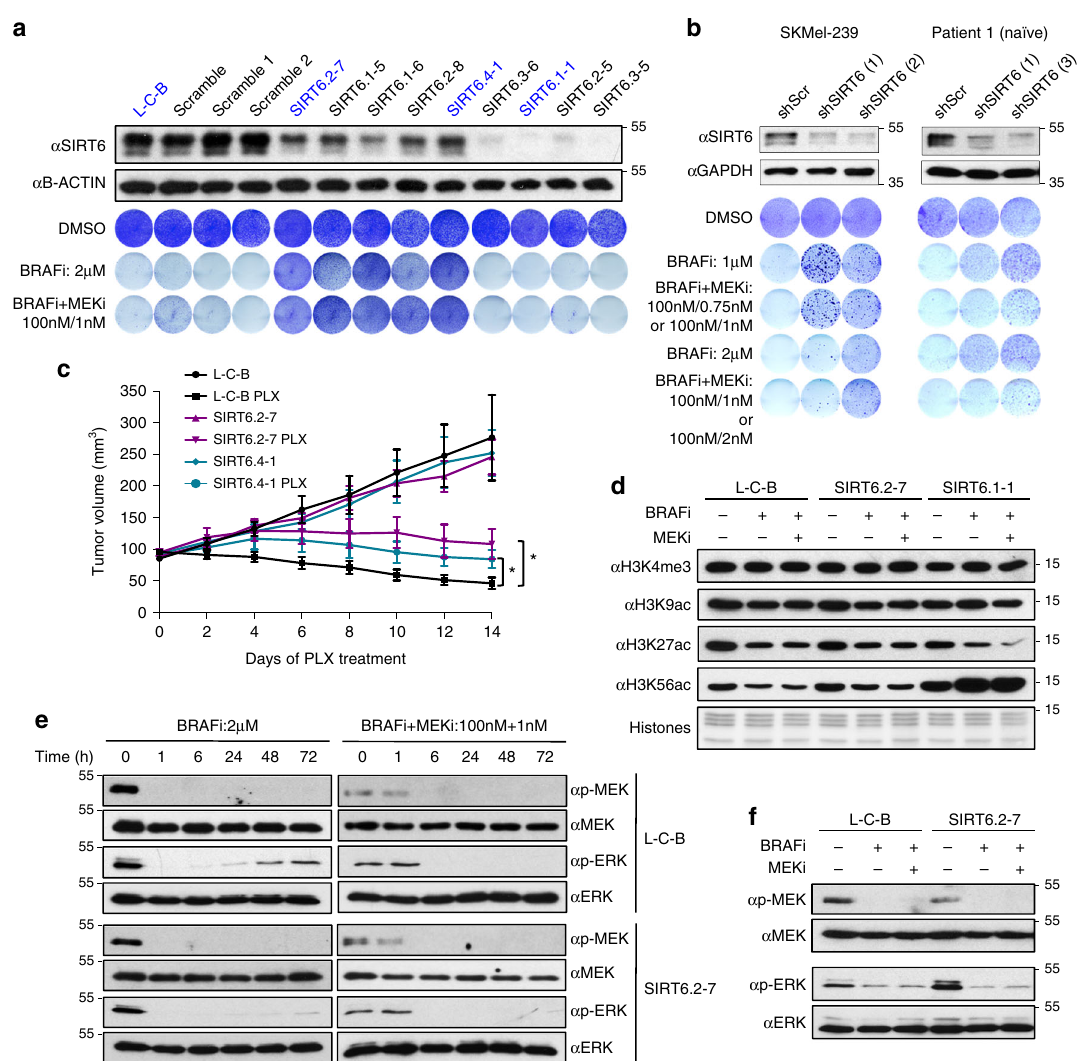
Fig. 2 SIRT6 haploinsuf fi ciency promotes resistance to MAPKi in BRAF V600E melanoma cells. a Immunoblot of SIRT6 in the indicated whole-cell lysates of SKMel-239 clonal CRISPR cell lines. B-Actin was used as a loading control (top; CRISPR clones used for follow-up experiments are indicated in blue). SKMel-239 cells were seeded at the same density and cultured in DMSO (1 week) or in the presence of the MAPKi (2 weeks) as indicated (bottom). b Immunoblot of SIRT6 in the indicated whole-cell lysates in SKMel-239 (left) and Patient 1 treatment-naive STC (right). GAPDH was used as a loading control. SKMel-239 and Patient 1 cells infected with control shRNA (scrambled) or shRNAs against SIRT6 (1, 2, or 3) were seeded at the same density and cultured in DMSO (1 week) or in the presence of MAPKi (4 and 5 weeks, respectively). c Quanti fi cation of tumor volume in nude mice bearing xenograft tumors of L-C-B, SIRT6.2 – 7, or SIRT6.4 – 1 cells that were fed a control or vemurafenib (PLX)-containing diet. Mann – Whitney test was performed for comparison between the three groups of mice treated with PLX. Data are mean ± SEM. * P < 0.05. n = 6 – 7. d The effect of BRAFi or BRAFi + MEKi treatment on H3K4me3, H3K9ac, H3K27ac, and H3K56ac in the indicated CRISPR cell lines after 4 days of treatment ± 2 µ M of BRAFi or 100 nM BRAFi + 1 nM MEKi. Histones used as a loading control. e The effects of BRAFi or BRAFi + MEKi treatment for the indicated periods of time on components of the MAPK signaling pathway in the indicated CRISPR cell lines. f Immunoblot of 2 µ M of BRAFi or 100 nM BRAFi + 1 nM MEKi treatment for 4 days on components of the MAPK signaling pathway in L-C-B and SIRT6.2 – 7